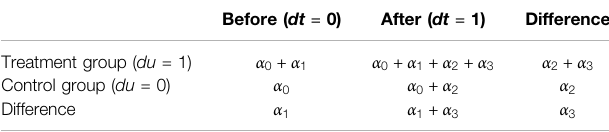
TABLE 1 | Policy effect analysis table of double difference